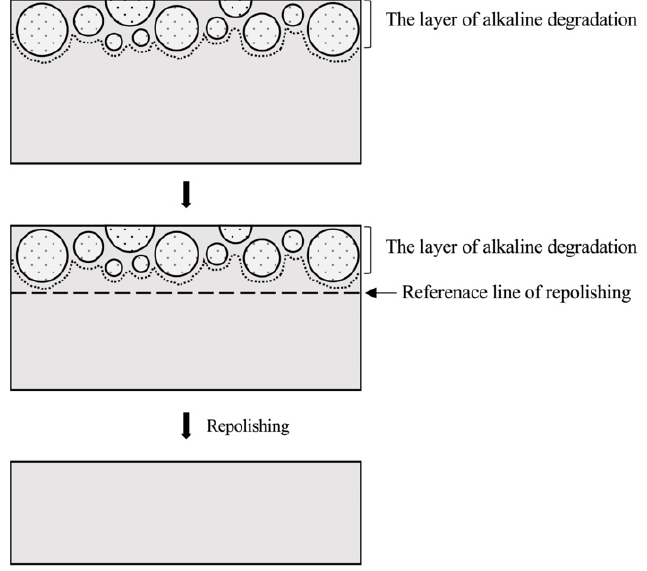
Figure 6. Schematic diagram of the repolished surface preparation procedure.